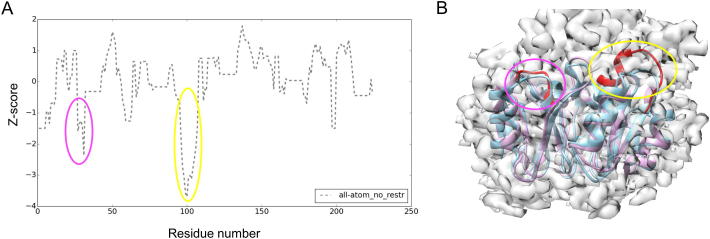
(A) Z-scores calculated based of SMOC profile for the model obtained from all-atom Flex-EM refinement without interface RB restraints. (B) Residue segments 95–106 and 26–32 with significantly low (<−2.0) Z-scores, are highlighted in yellow and pink respectively. The target density map (3.3 Å resolution map of 60S ribosome from D. discoideum bound to eIF6 (EMD-3145)) is shown in transparent grey.